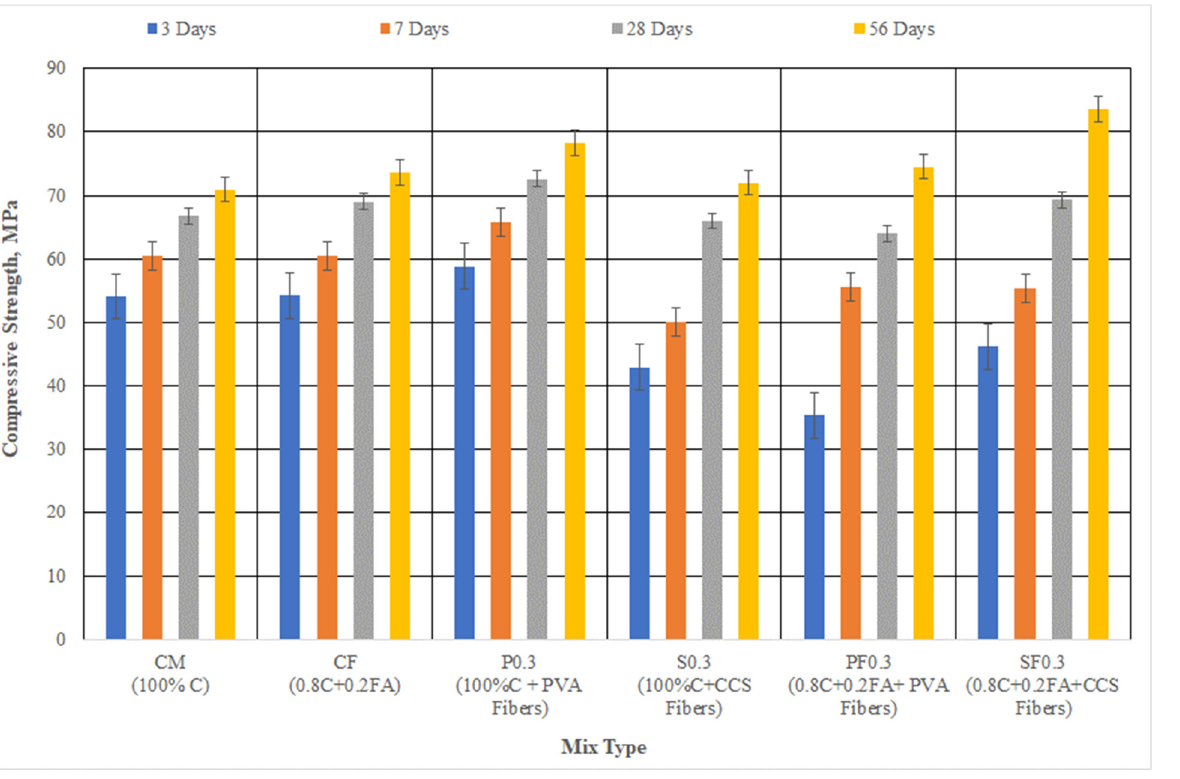
Figure 5. Compressive strength development in different concrete mixes at different ages. Table 4. Split tensile and flexure strength of concrete mixes determined at 28